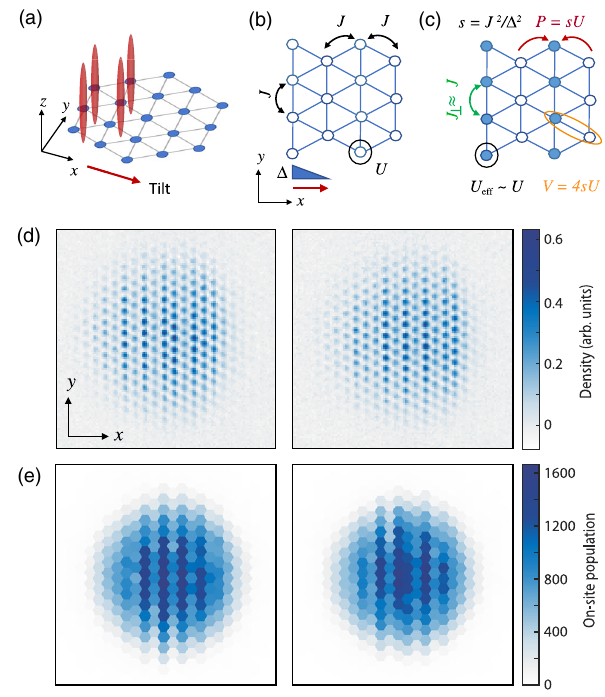
FIG. 1. Bose-Einstein condensates in strongly tilted optical lattices. (a) The system consists of a triangular lattice of tubes with a tilt applied perpendicularly to a lattice vector. (b) The system can be described by a Hubbard model with tunnel coupling J , on-site interaction U , and energy offset Δ along the tilt direction. (c) In the large tilt limit the system can be described by an effective Hamiltonian with no tilt and no single- particle tunneling in the tilt direction, but pair tunneling P and nearest-neighbor interaction V with a strength set by sU with s ¼ ð J= Δ Þ 2 . Tunneling perpendicular to the tilt J ⊥ and the effective on-site interaction U remain approximately un- eff changed. (d) Experimental images of the spatial density show the spontaneous formation of charge density waves with wave vector parallel to the tilt direction. The two example images are for identical parameters of a hold time of 60 ms and tilt with energy offset Δ ¼ h × 1 . 4 kHz, but one shows a domain wall in the center of the cloud and the other does not, directly reflecting the spontaneous nature of the pattern. The tunnel coupling is J ¼ h × 13 Hz throughout the paper. (e) c -field simulation for the same parameters as in (d). The simulation does not model the density modulation within the lattice sites and the density distribution is therefore shown as tiled